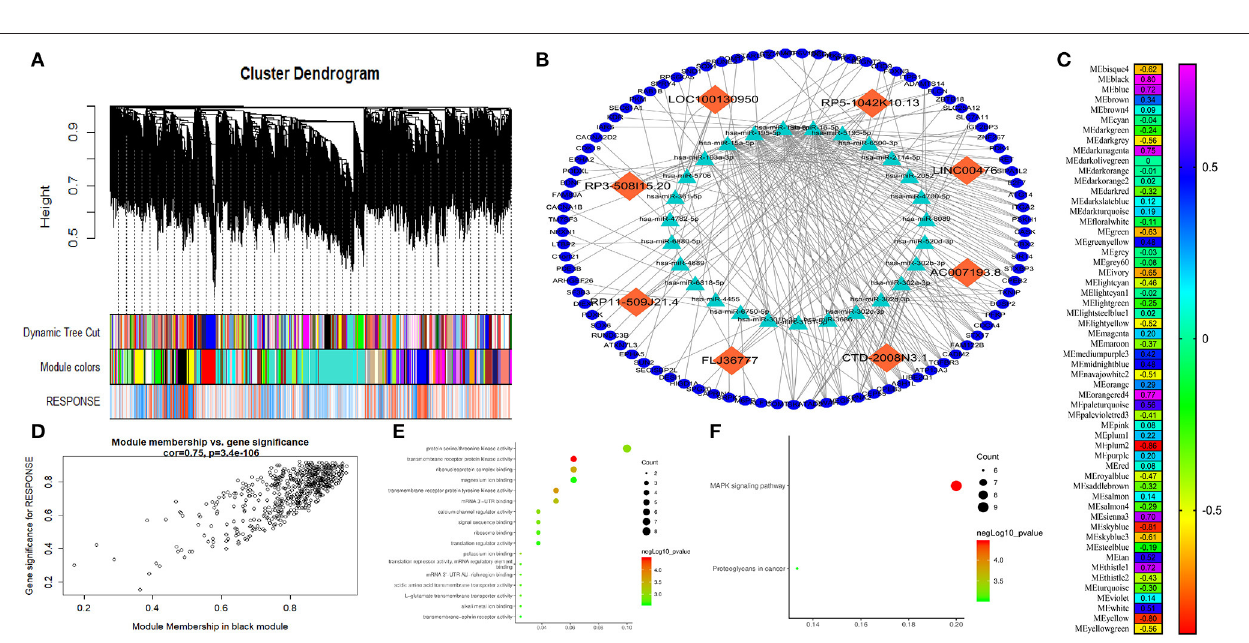
FIGURE 2 | indicated the upregulated genes of messenger RNAs (mRNAs), and the green dots indicated the downregulated genes of mRNAs. (C) GO functional analysis of the top 10 functional classifications of the upregulated genes. (D) GO functional analysis of the top 10 functional classifications of the downregulated genes.